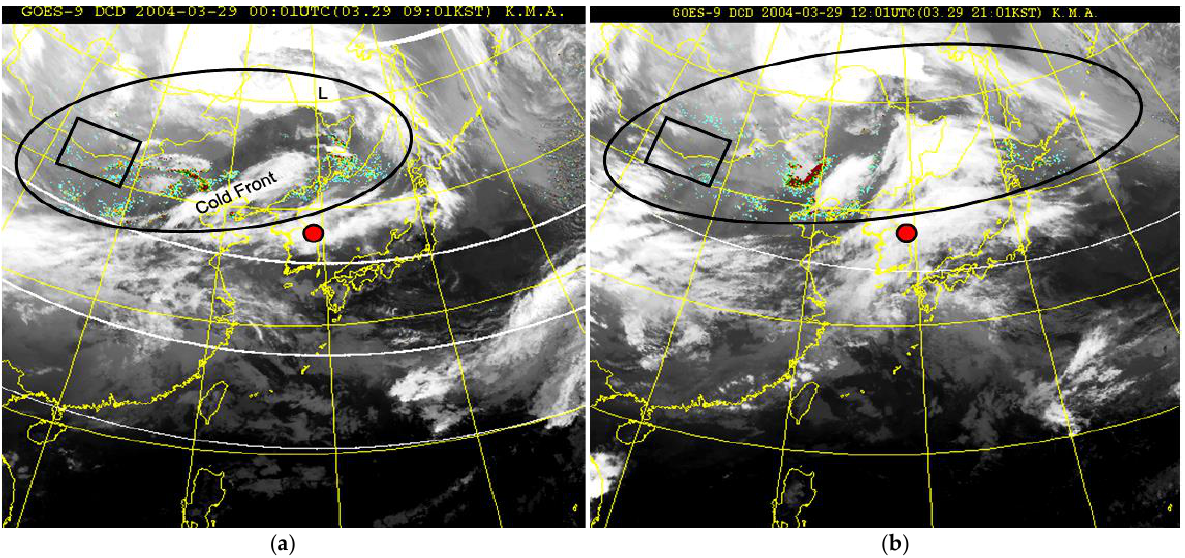
Figure 2 . Hourly concentration ( μg /m 3 ) of PM 10 , PM 2.5 , and PM 1 at an aerosol sampling point of Gangwon Meteorological Administration (37 ° 4 5′ N, 128°5 4′ E; 20 m height over the Mean Sea Level) in Gangneung city, from March 26 to 4 April 2004.